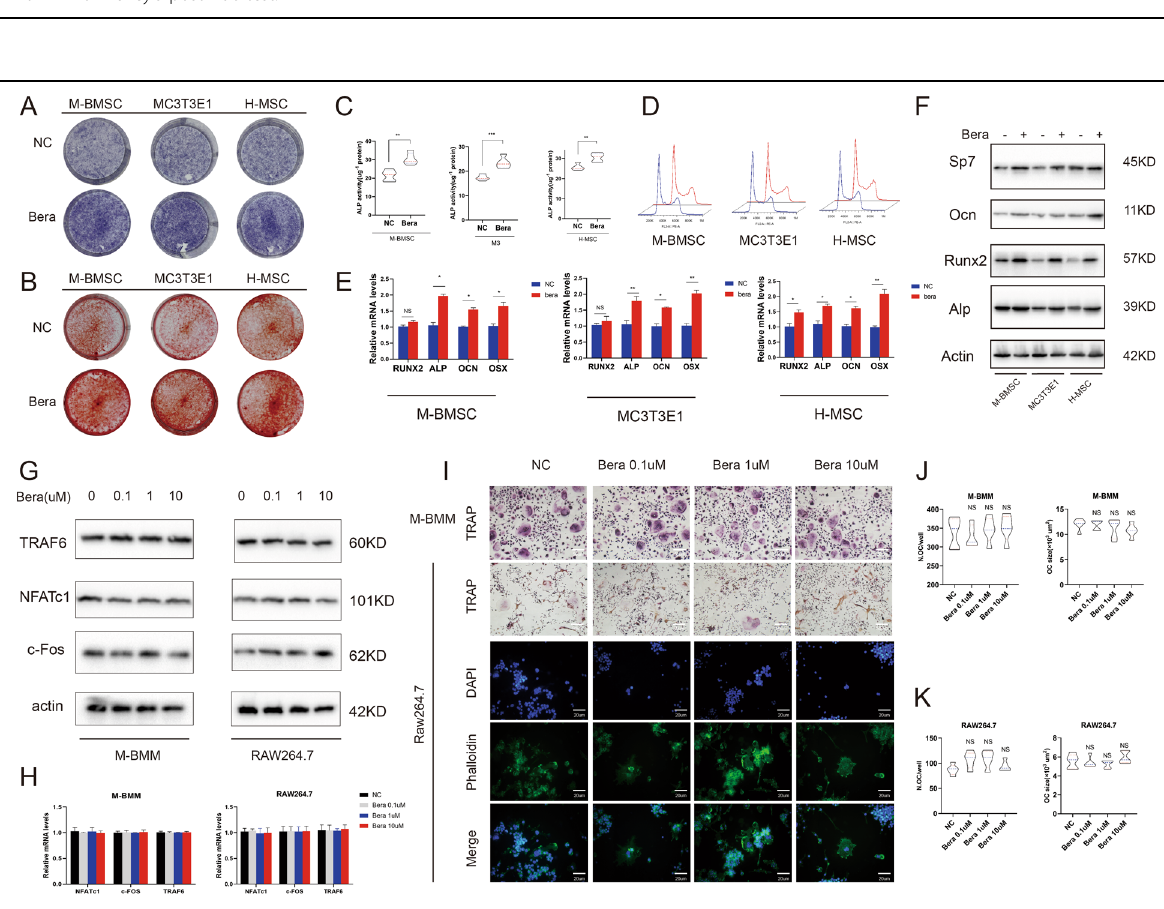
Fig. 3 Beraprost promotes osteoblastogenesis but has no direct effect on the differentiation of osteoclast in vitro. A , B Representative images of ALP and ARS staining. C Quantitative analyses of ALP activity. Results are shown as mean ± SD; n = 5, ** P < 0.01 and *** P < 0.001 by t test. D Cell cycle was measured by fl ow cytometry. E Quantitative RT-PCR analysis of mRNA expression of Runx2, Alp, OCN, and OSX in beraprost-treated BMSCs. Results are shown as mean ± SD; n = 5; * P < 0.05, ** P < 0.01, and *** P < 0.001 by t test. F Western blotting images showing protein expression of Runx2, ALP, OCN, and OSX in beraprost-treated BMSCs. G Western blotting images showing protein expression of TRAF6, NFATc1, and c-Fos in beraprost-treated M-BMM and Raw264.7 cells. H Quantitative RT-PCR analysis of mRNA expression of TRAF6, NFATc1, and c-Fos in beraprost-treated M-BMM and Raw264.7 cells. Results are shown as mean ± SD; n = 5, ns ( P > 0.05) by ANOVA with Tukey ’ s post-hoc test. I Representative images of TRAP staining of M-BMM and Raw264.7 after 7 days of osteoclast differentiation. Scale bar, 50 µm. Representative images of fl uorescent staining of Raw264.7 cells are shown. The cytoskeleton was stained with FITC-conjugated phalloidin and the nucleus was stained with DAPI. RANKL (30 ng/mL) was used in all groups. Scale bar, 20 µm. J , K Number and size of osteoclasts. TRAP-positive cells with at least three nuclei were de fi ned as osteoclasts. n = 5; ns ( P > 0.05) by